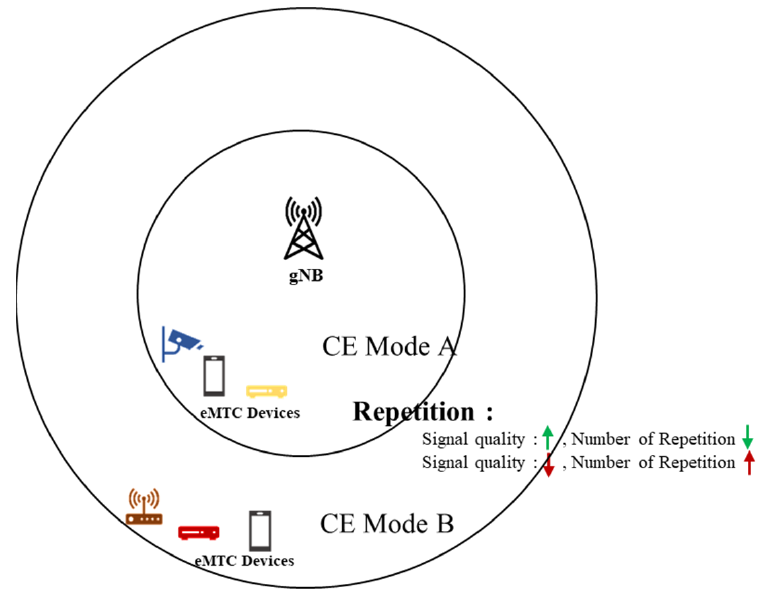
Figure 1. CE level and repetitions for eMTC.